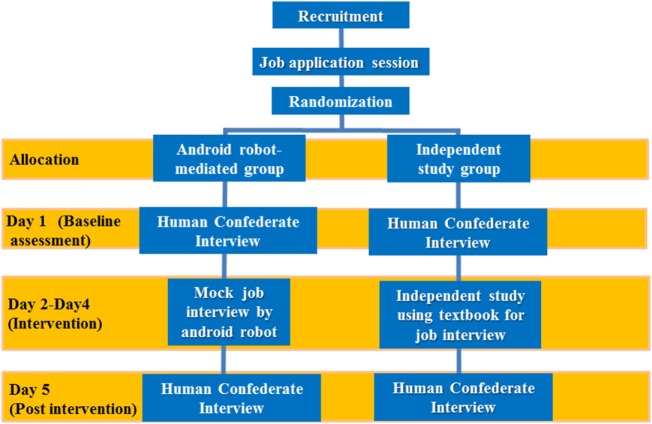
Participant flow.